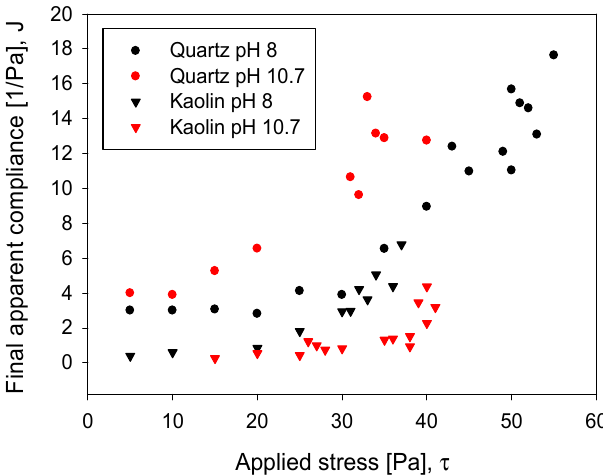
Figure 10. Final apparent compliance as a function of stress for quartz and kaolin slurries.